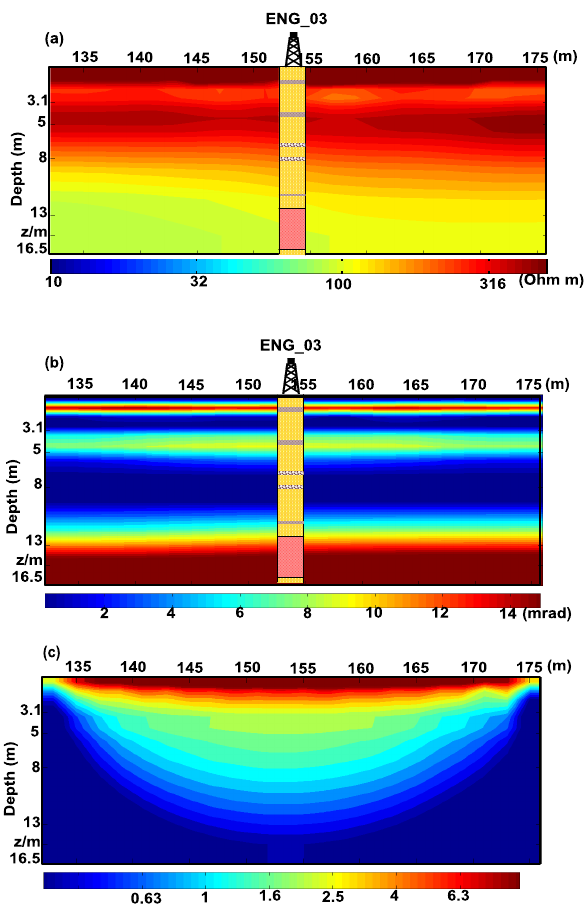
Fig. 3. The 2D IP inversion results of P1 profile (for location see Fig. 1). (a) The resistivity 60 Fig. 3. The 2-D IP inversion results of profile P1 (for location see amplitude (|ρ|), (b) conductivity phase shift ( ) and (c) coverage section (0.625 Hz data). 61 Fig. 1). (a) Resistivity amplitude ( | ρ | ), (b) conductivity phase shift ( ϕ ) and (c) coverage section (0.625Hz data).